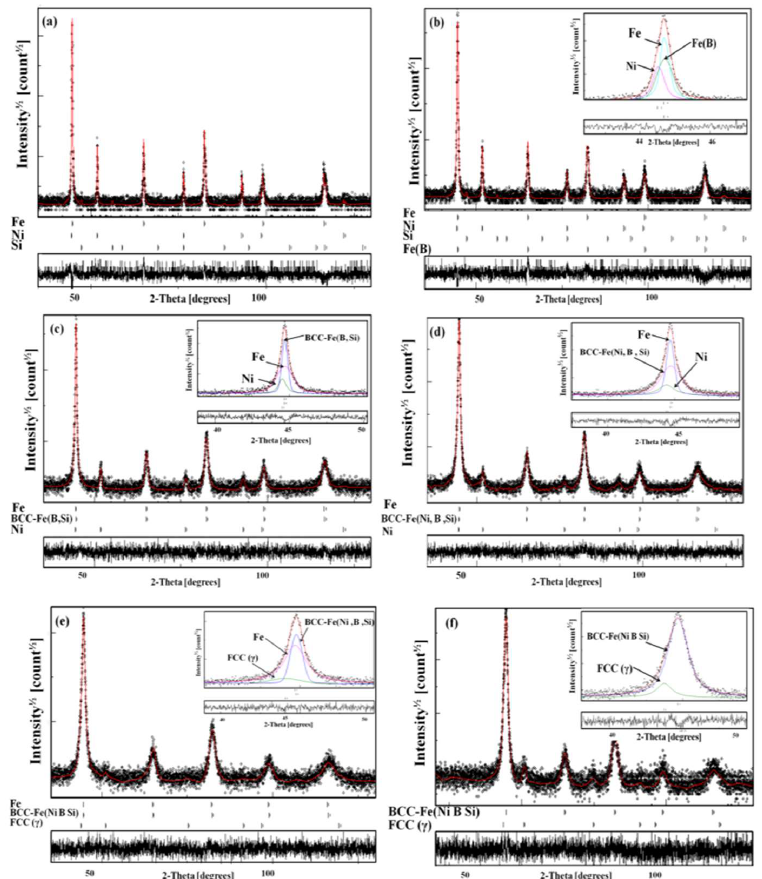
Figure 3. Rietveld refinement of the XRD pattern of the Fe 70 Ni 12 B 16 Si 2 powder ( a ) before milling and after ( b ) 1 h, ( c ) 5 h, ( d ) 25 h, ( e ) 50 h and ( f ) 150 h. The peak (110) fitted with the pseudo-Voigt function is shown in the insert. Table 2. The chemical mixing enthalpy (Δ 𝐻 (cid:3036)(cid:3037)(cid:3040)(cid:3036)(cid:3051) ) of binary equiatomic alloys calculated by Miedema’s approach [35].